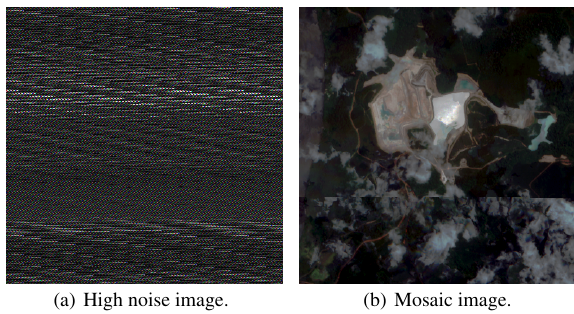
Figure 3. Examples of bad images in acquisition of